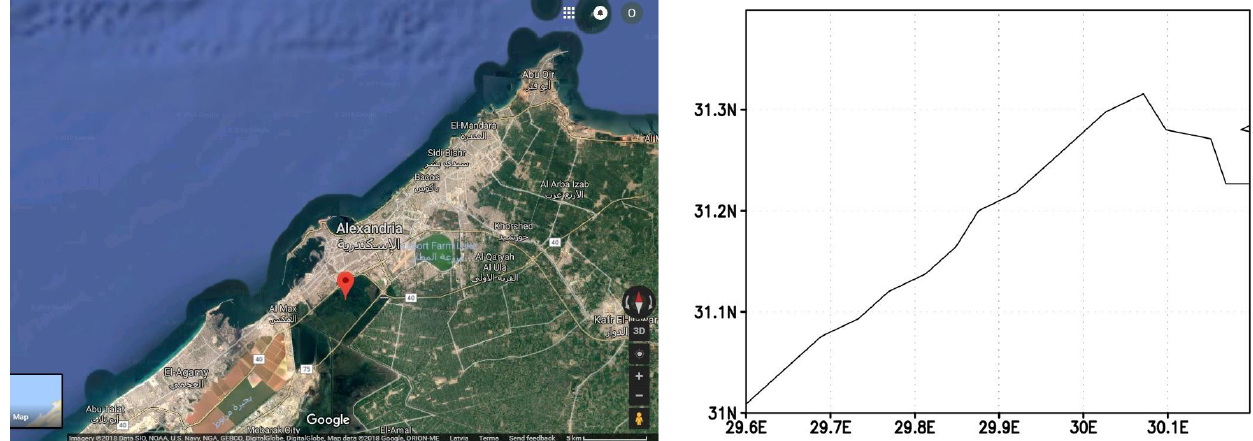
Figure 5. Lake Mariout on Google Earth (to the left) (Google Earth, https://earth.google.com/web/, 2019) and on ECOCLIMAP2 (to the